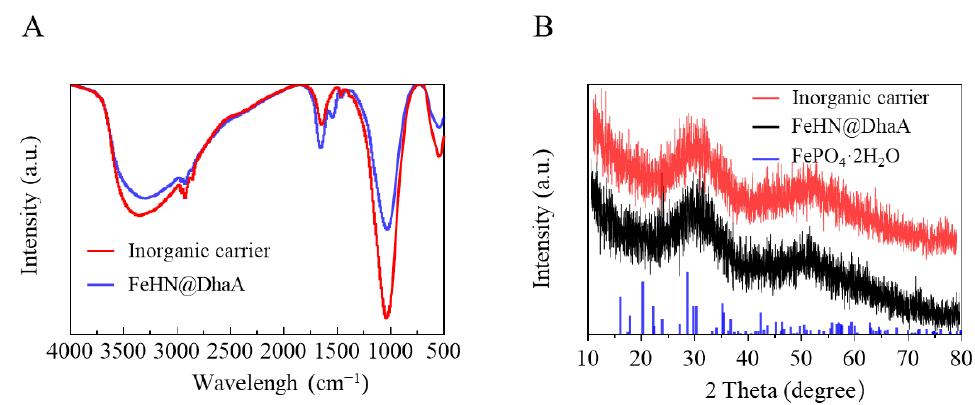
Figure 5. FT-IR spectra of inorganic carrier and immobilized DhaA ( A ); XRD patterns of inorganic carrier and immobilized DhaA ( B ).